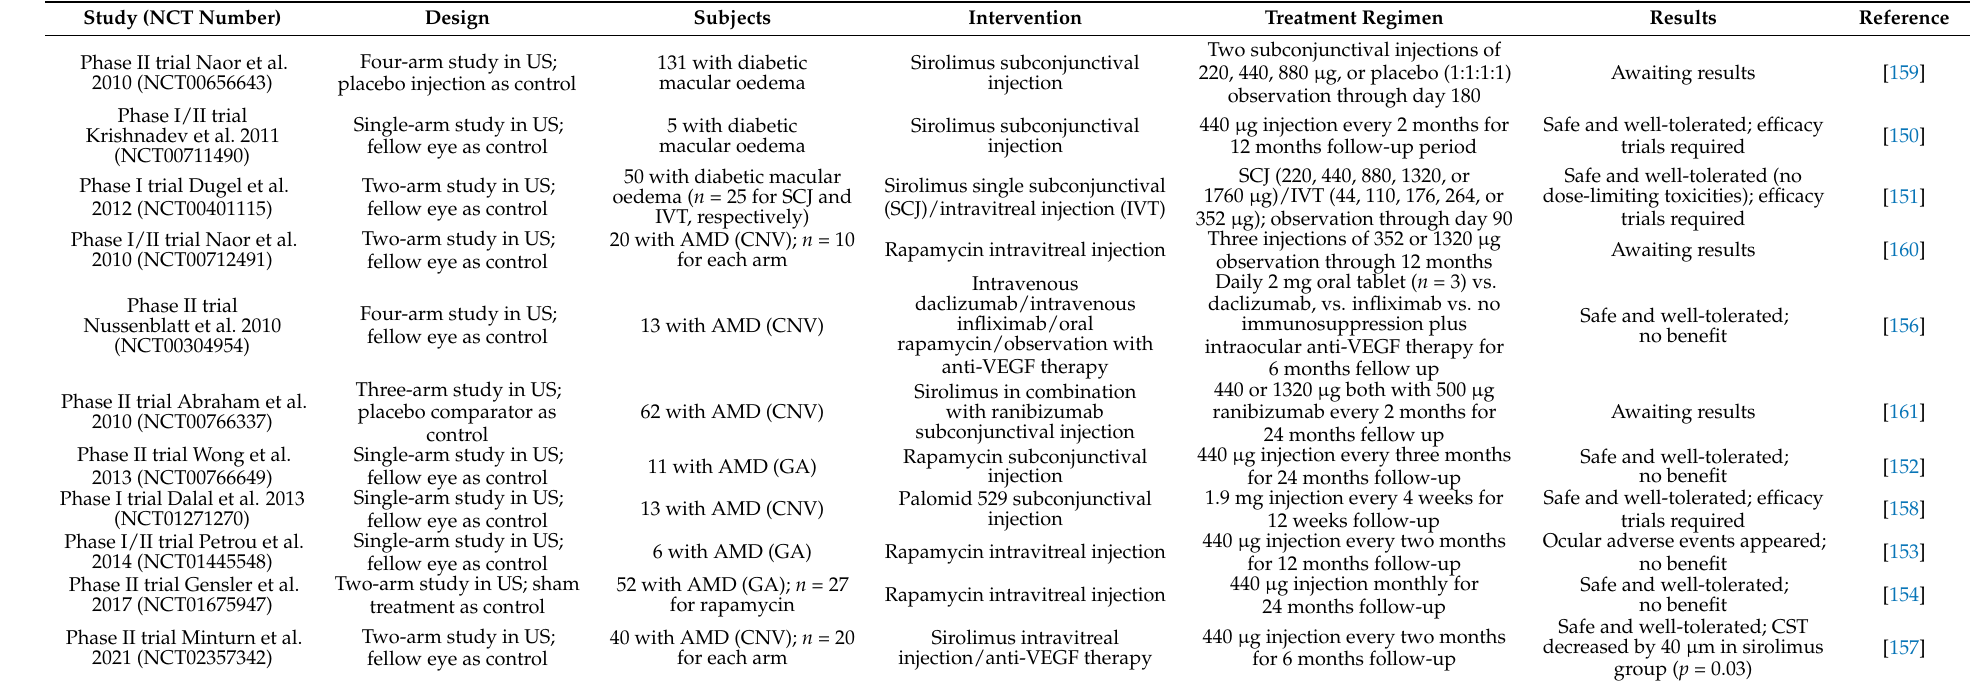
Table 5. Summary of clinical trials of mTOR inhibitors in ocular neurodegenerative